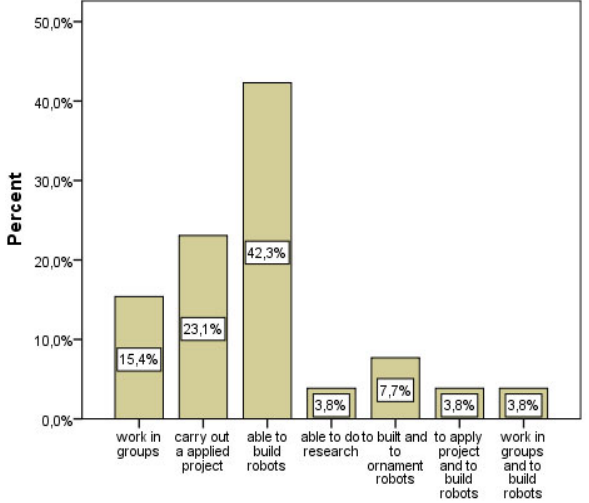
Figure 5. K-12 students’ answer to the question “What did you like the most in the project area theme?” Figure 6. K-12 students’ answer to the question “Degree of difficulty in performing tasks in the project